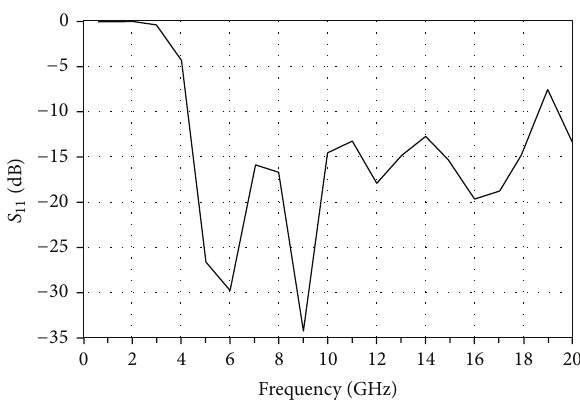
Figure 9: Simulated reflection coefficient ( 𝑆 11 parameter) of the O - shaped antenna composed of six unit